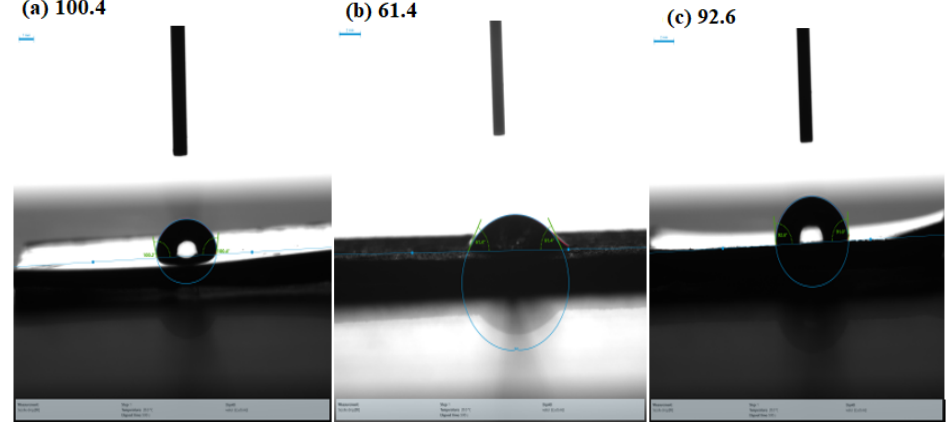
Figure 11. Water contact angle analysis: ( a ) polished MS, ( b ) after 6 h immersion in 1 M HCl, ( c ) after 6 h immersion in 1 M HCl + CMEA.